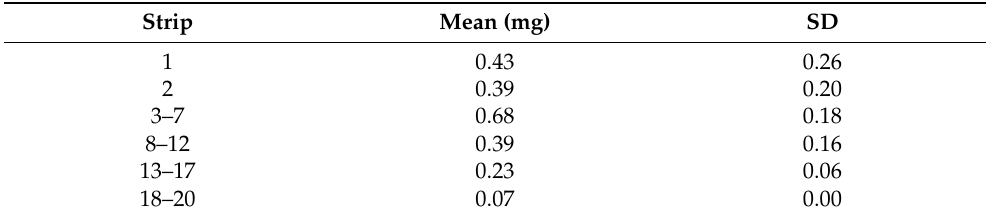
Table 2. Amount of skin retired (mg) for each group strip ( n = 3) with its standard deviation. Strip Mean (mg)